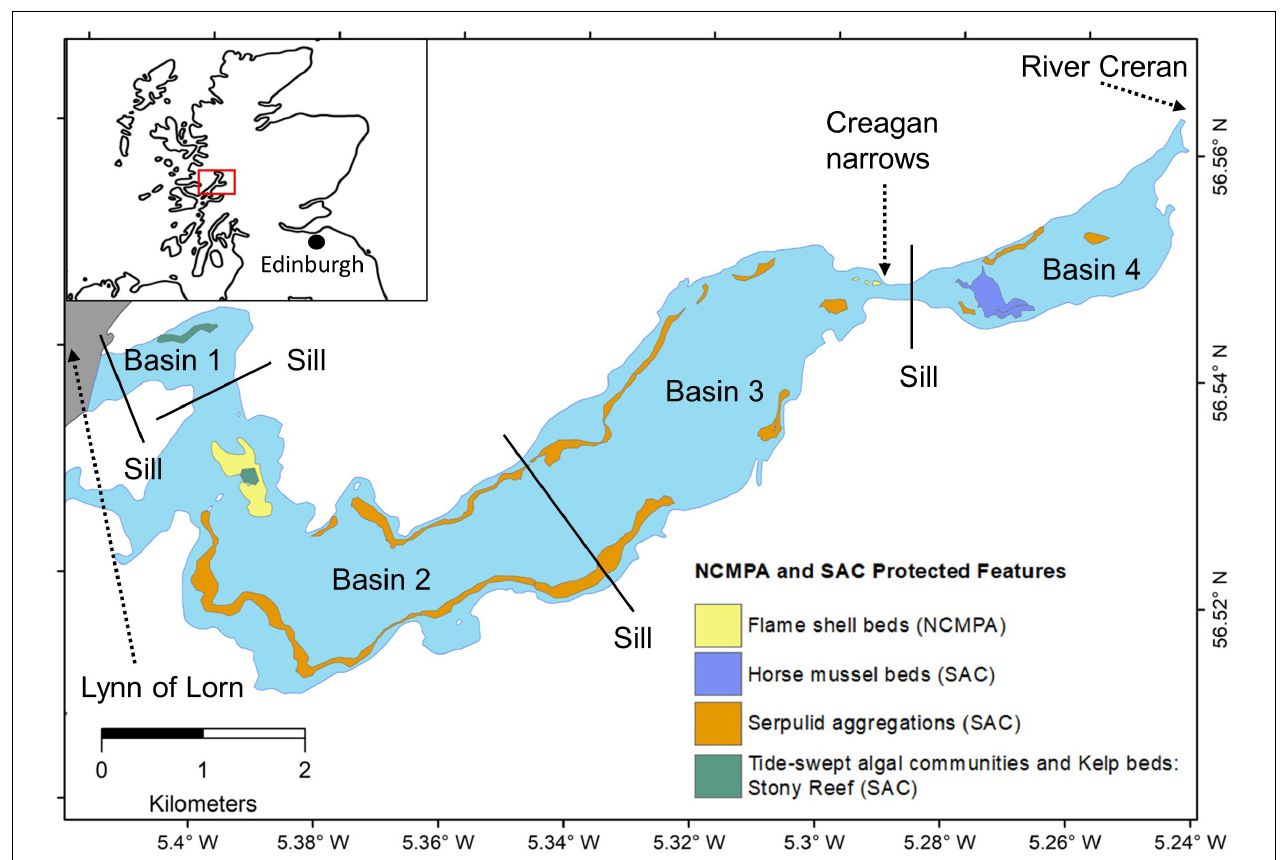
FIGURE 1 | Location map for the study area. Loch Creran, on the west coast of Scotland, is highlighted in the red box (inset); The four basins and sill locations are indicated. Priority marine features protected under the EC Habitats Directive Special Area of Conservation (SAC EU Code: UK0030190) and Scottish Waters Nature Conservation Marine Protected Area (Loch Creran NCMPA) are highlighted to show the areas that were avoided during grab sampling. Map adapted from Black et al.